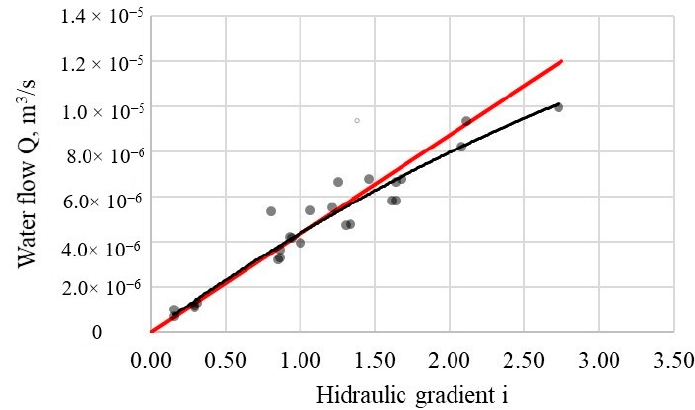
Figure 6. Dependency of flow rate of the spilled water through washed sand with optimal compaction on the different hydraulic gradients.